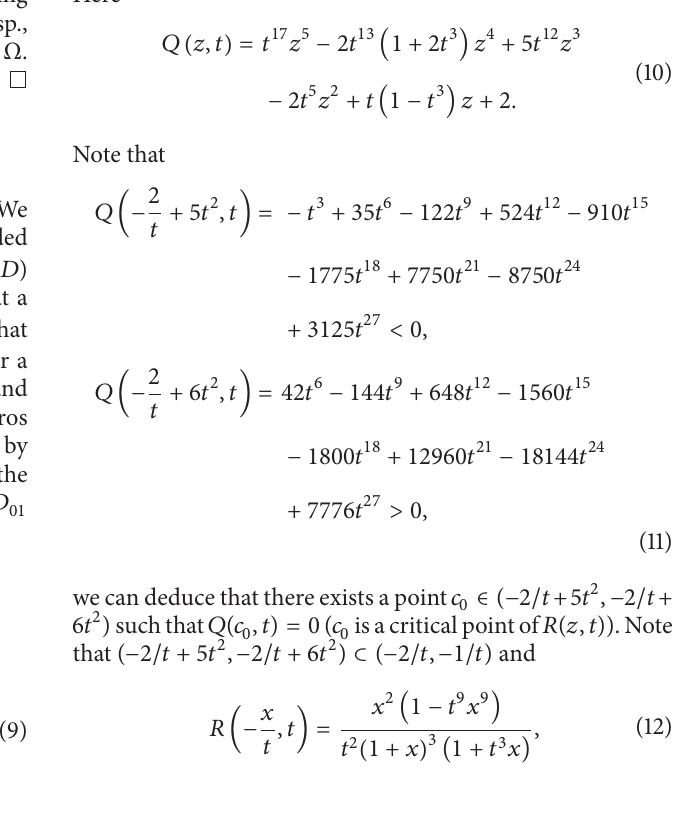
at least one Fatou component 𝐷 01 ( ̸= 𝐷 00 ) of 𝑅 −1 (𝐷 00 ) . Noting that there are three (resp., two) zeros of 𝑅(𝑧, 𝑡) in Ω (resp., 𝐷 00 ), this implies that